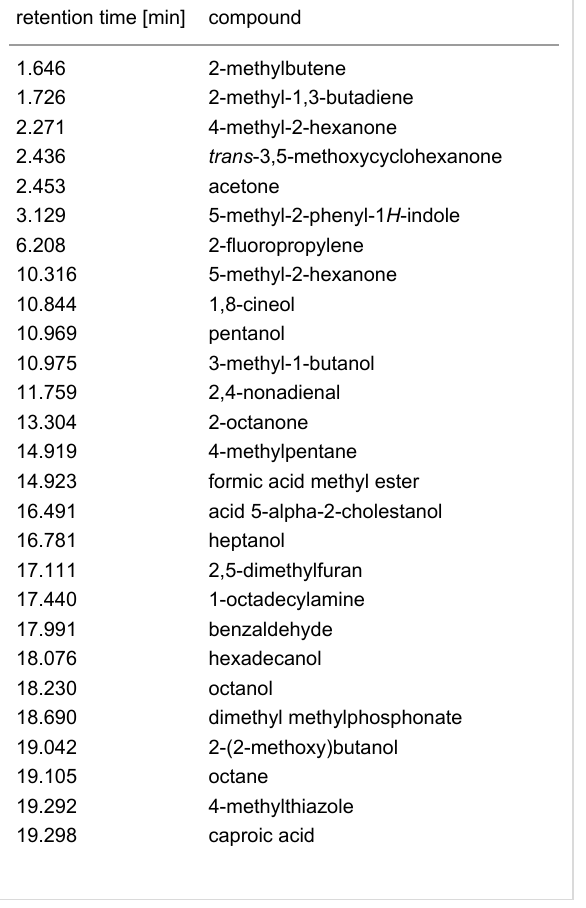
Table 2: Volatile chemical compounds identified, using SPME-GC-MS, in the contaminated water.